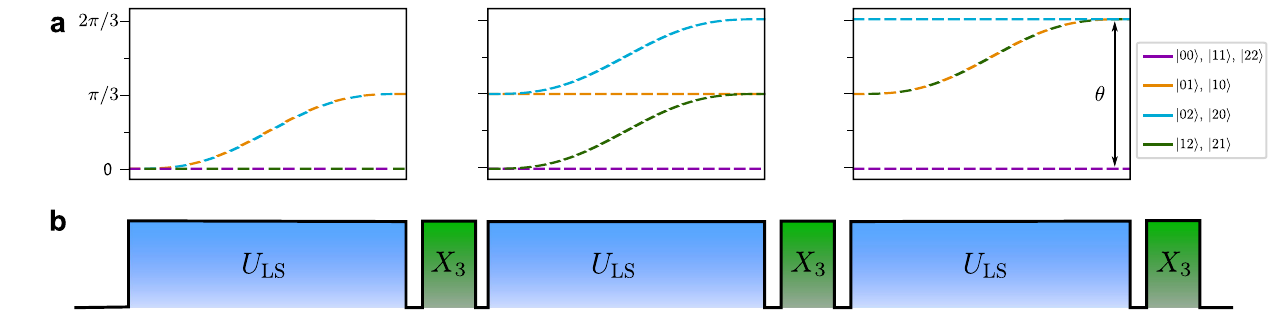
Fig.3|Applicationofthegateontwoqutrits.a Phaseevolutionofthetwo-qutrit statecomponentsrelativetothe ∣ 00 i groundstateduringtheapplicationoftheLS gate pulses. States ∣ 01 i and ∣ 10 i are shown inorange, ∣ 02 i and ∣ 20 i inblue, and ∣ 21 i and ∣ 12 i ingreen. The equalelectronicstates ∣ 00 i , ∣ 11 i , ∣ 22 i in purple donot acquire